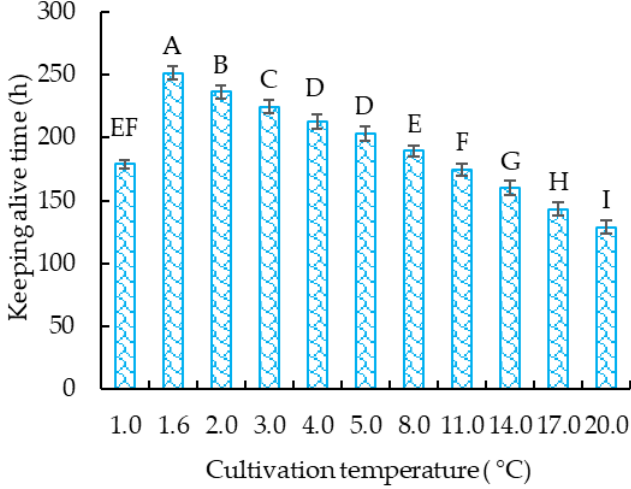
Figure 2. Effects of different temperatures on the survival time of the crucian carp. Different letters above the standard deviation represent significant differences between the groups ( p < 0.05).